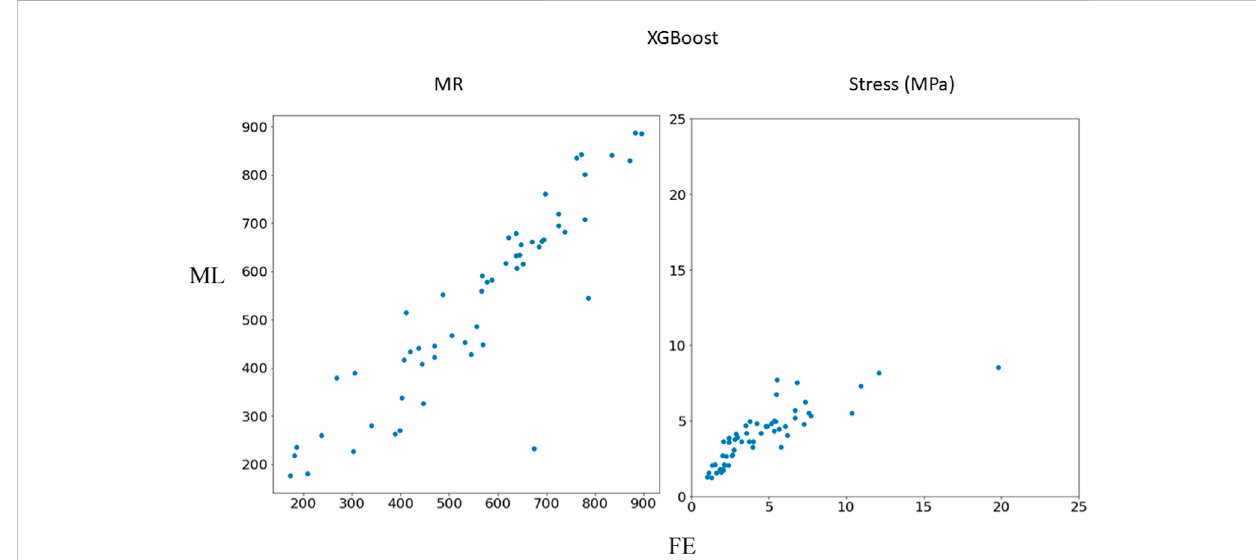
FIGURE 4 Comparison between FE results and XGBoost predictions. Python (3.7, https://www.python.org/) was used to create this fi